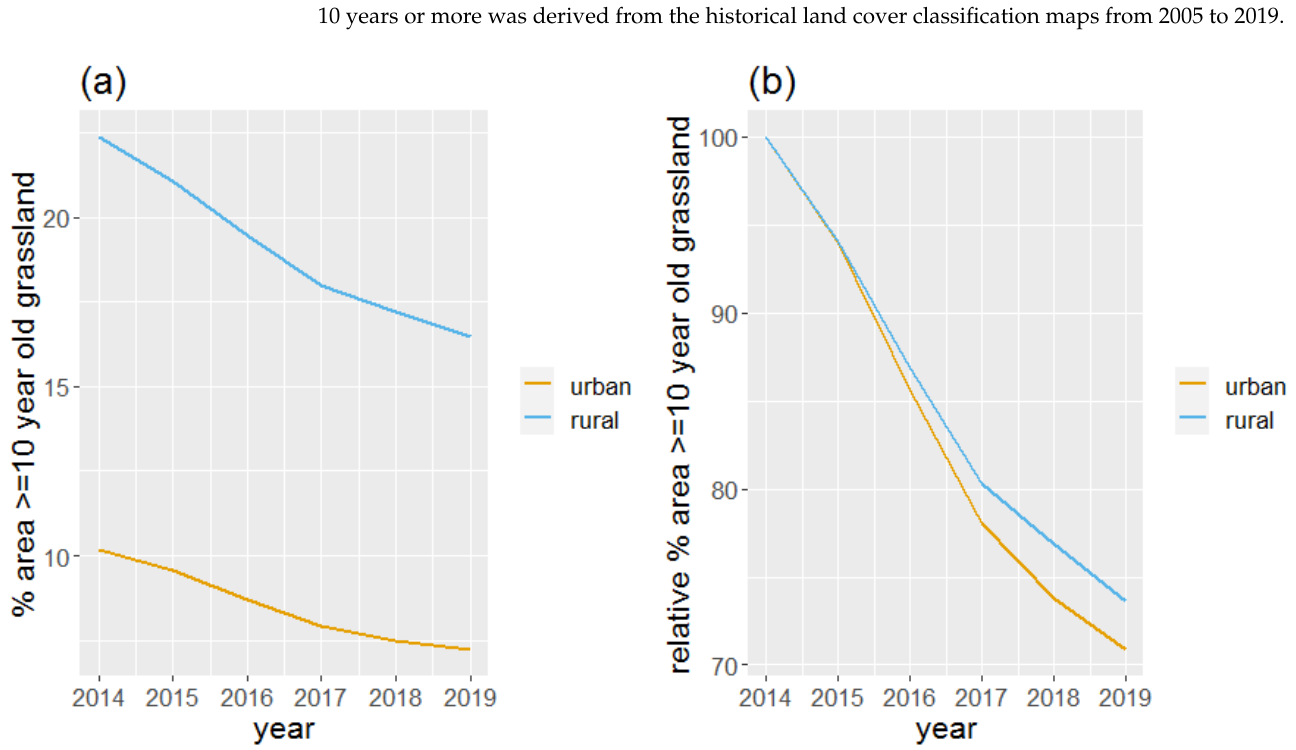
Figure 8. ( a ) Percentage of area long-term grassland aged10 years or older from 2014 to 2019 in urban versus rural areas. ( b ) Relative % area change of long-term grassland from 2014 to 2019 in urban versus rural areas.